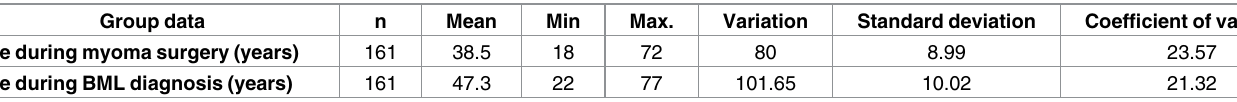
Table 2. Group descriptive